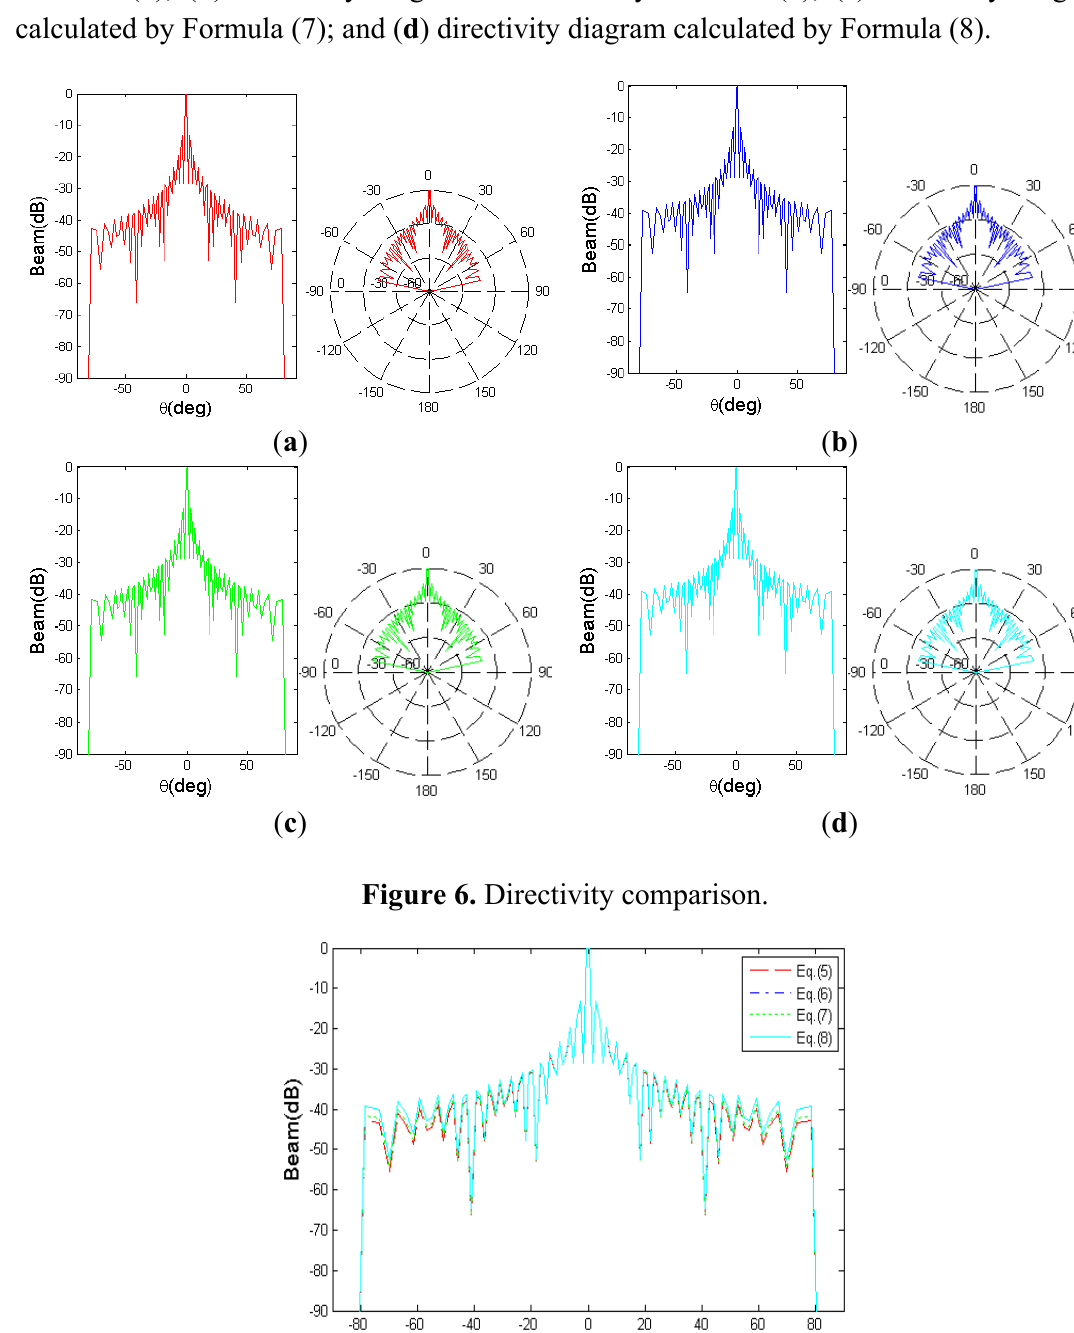
Figure 5. CMUT Linear Array Directivity Diagram: ( a ) directivity diagram calculated by Formula (5); ( b ) directivity diagram calculated by Formula (6); ( c ) directivity diagram calculated by Formula (7); and ( d ) directivity diagram calculated by Formula (8).